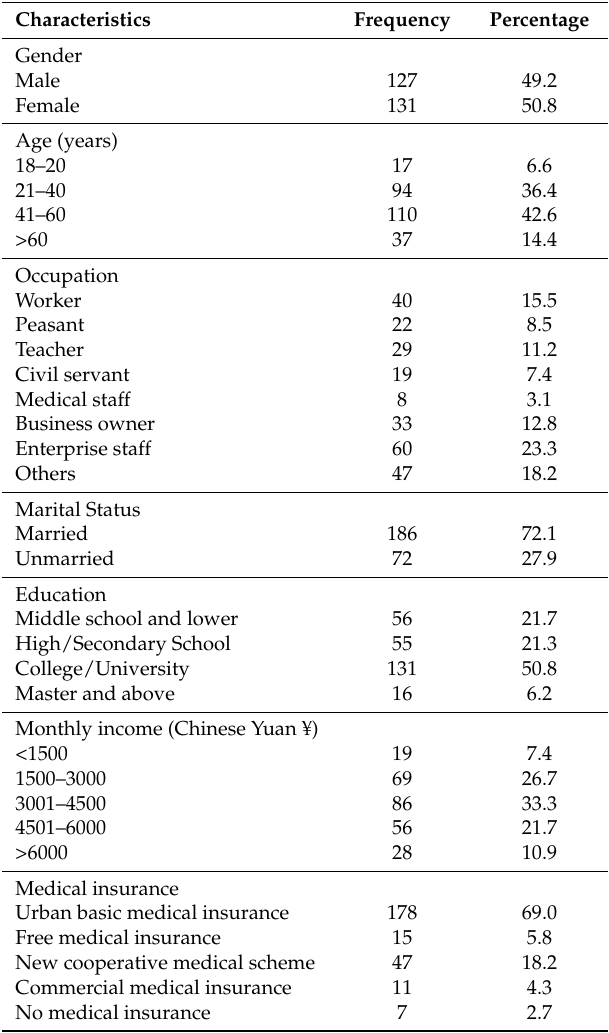
Table 1. Characteristics of the study respondents (N =